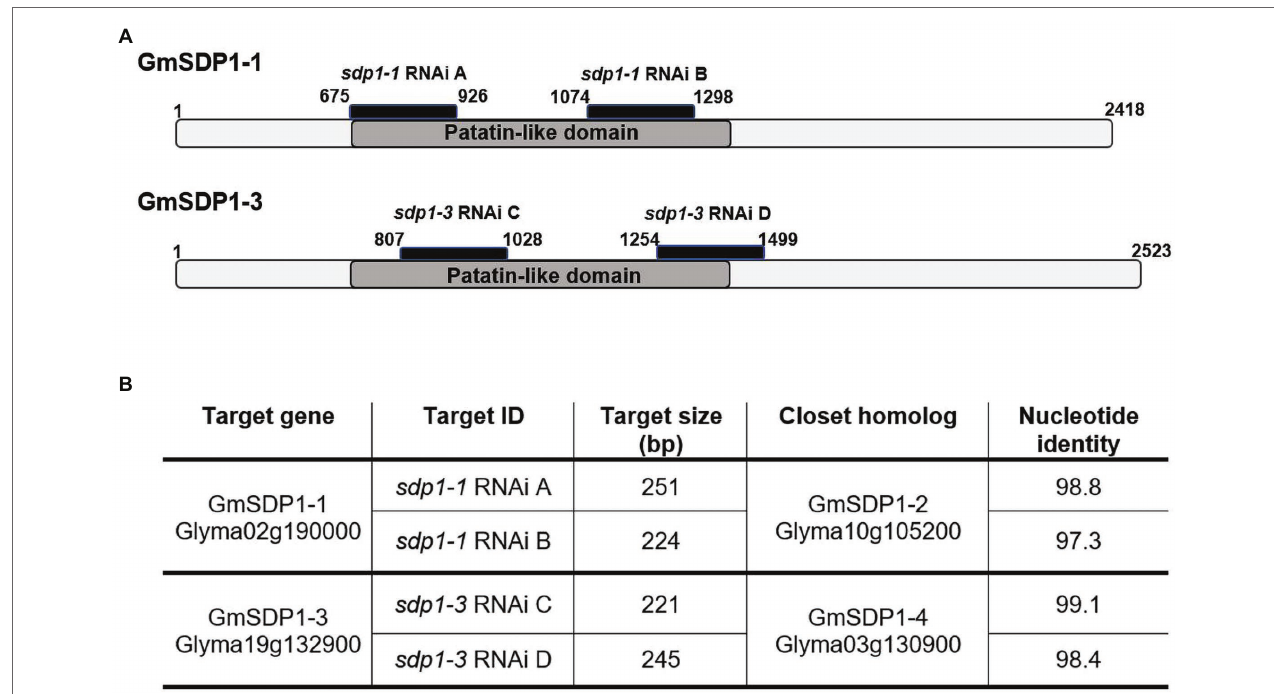
FIGURE 3 | RNAi target design for SDP1 lipases in soybean. (A) Schematic representation of the two lipase genes selected for suppression, showing the region of the RNAi target sequences in black and patatin-like domains in dark grey. Numbers indicate the position of the sequence from the start codon. (B) Table showing identity values between the target sequences and corresponding regions of the closest GmSDP1